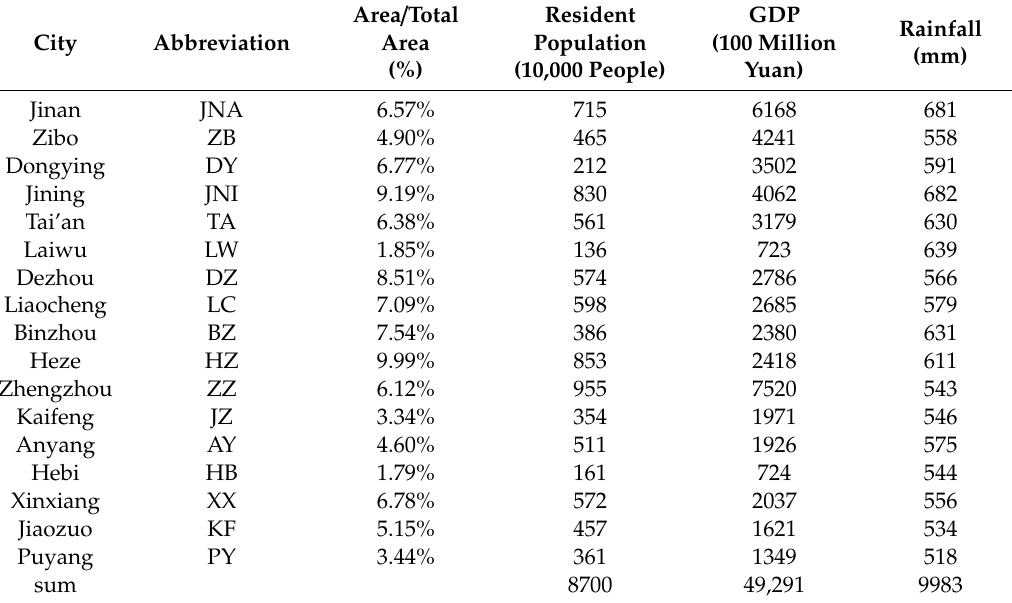
Table 1. Basic overview of urban agglomerations in the lower Yellow